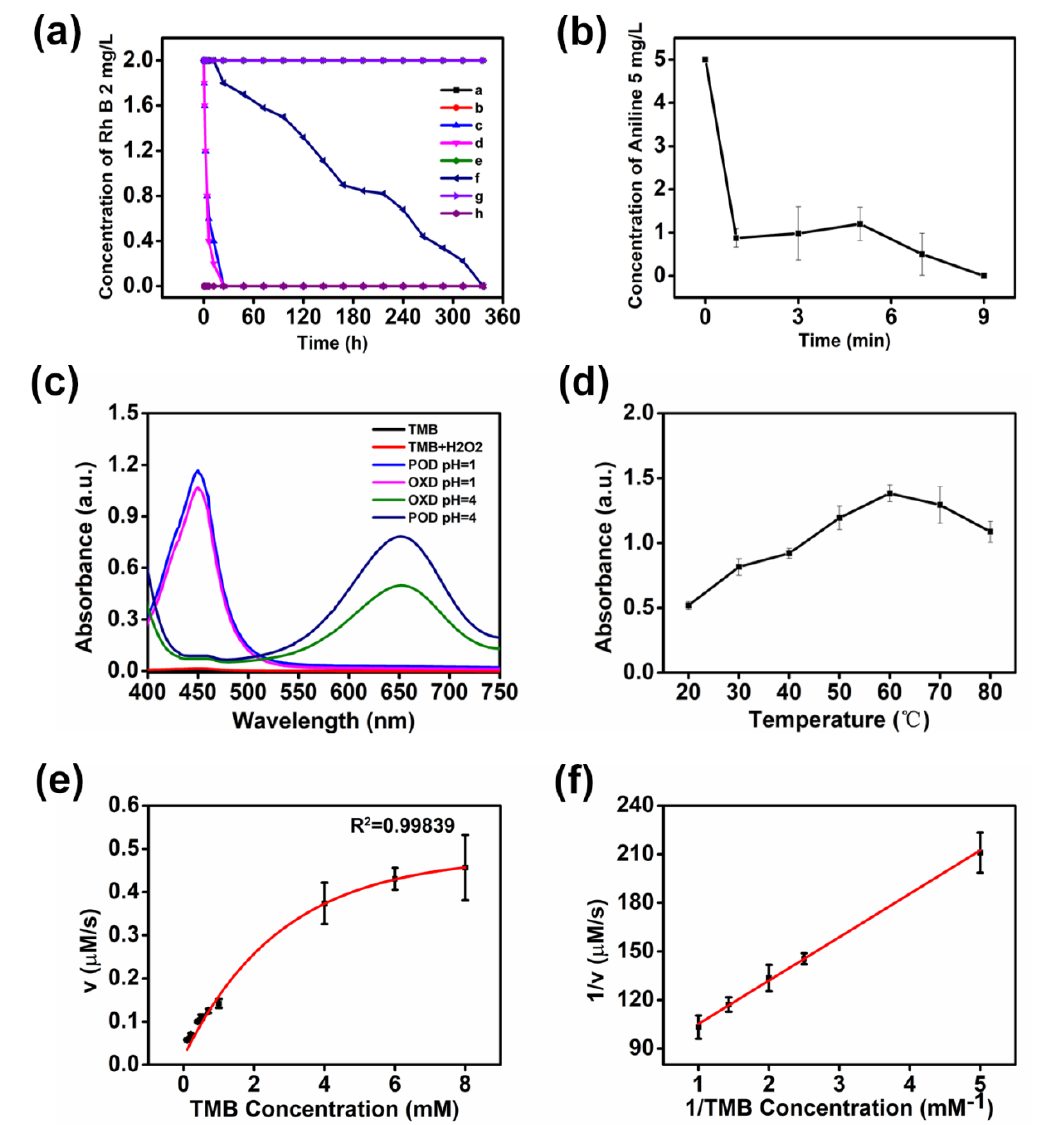
Figure 3. The degradation of Rh B with different materials ( a ), (a) Rh B; (b) Rh B, pH = 1.0; (c) acid-treated clay; (d) acid-treated clay, pH = 1.0; (e) CeO 2 ; (f) CeO 2 , pH = 1.0; (g) CeAY; (h) CeAY, pH = 1.0; The degradation efficiency of aniline (CeAY 2 mg mL − 1 , room temperature, pH = 1, 5 mg L − 1 ) ( b ); the peroxidase-like and oxidase-like activity of CeAY (0.04 mg mL − 1 , 2 mM TMB, pH = 1) ( c ); The temperature effort (0.04 mg mL − 1 , 2 mM TMB, pH = 1) ( d ); Steady-state kinetic and catalytic mechanism of the catalytic activity of the CeAY. The velocity (v) of the reaction was evaluated using 50 µ L of CeAY (0.04 mg mL − 1 ) in 0.1 mol L − 1 HCl (pH = 1.0) at 60 ◦ C. ( e , f ). The error bars stand for the standard deviation ( n =